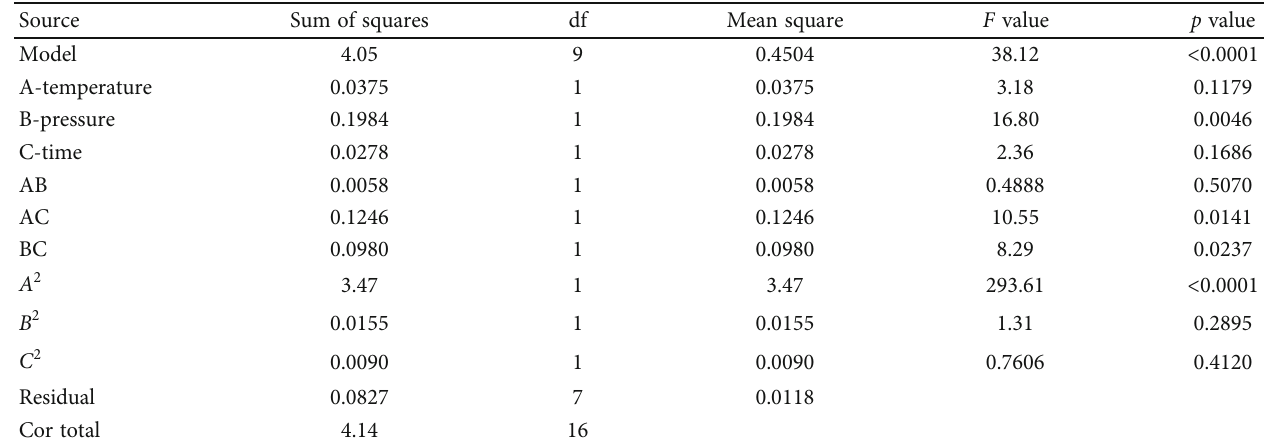
Table 4: ANOVA for impact